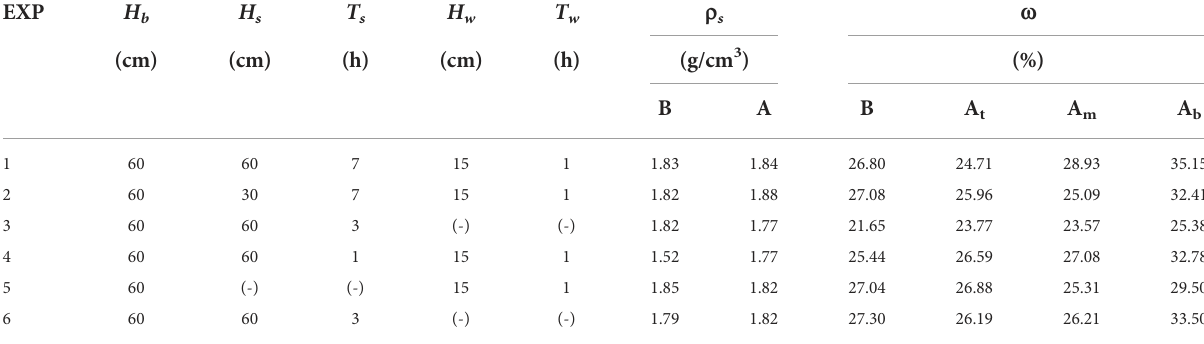
TABLE 2 Summary of experimental parameters.